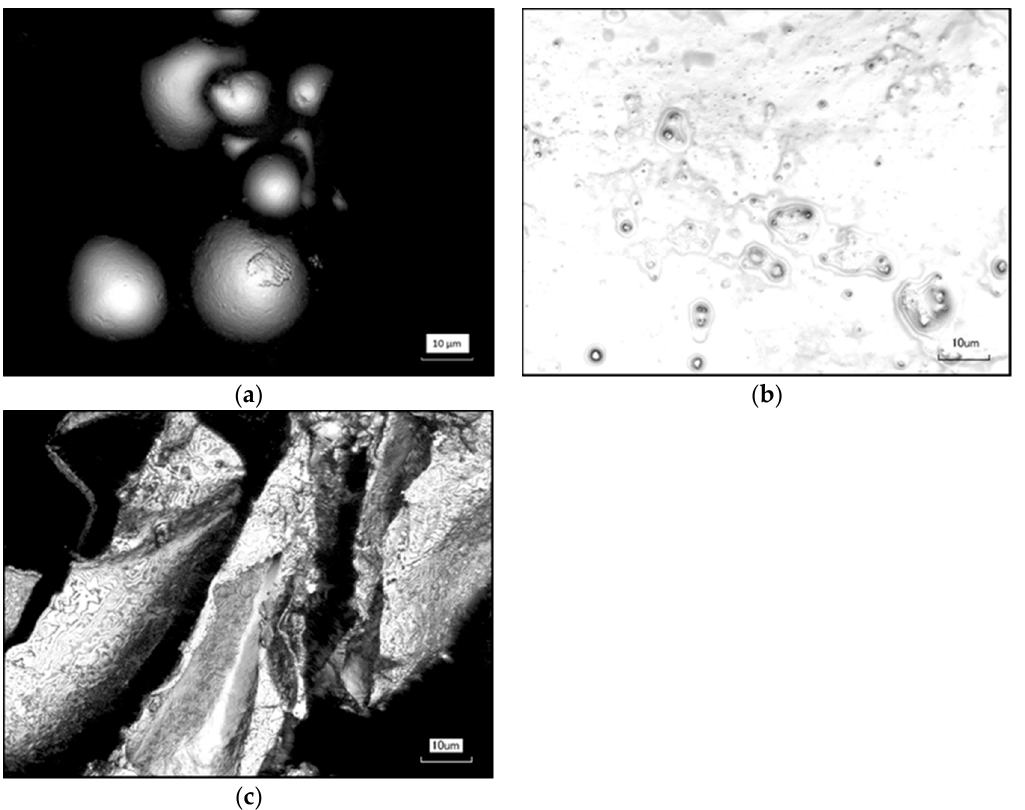
Figure 3. LSM of ( a ) native potato starch, ( b ) starch SAP St90 and ( c ) starch SAP St60 images.